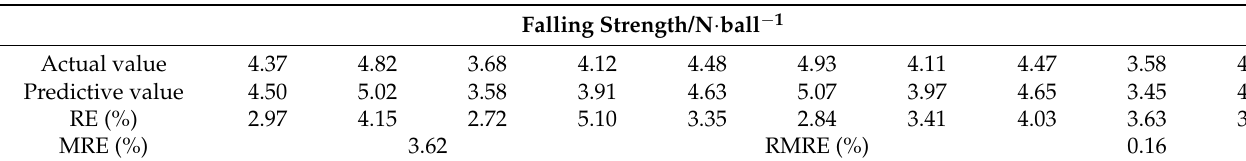
0.38 Figure 8. Variation trend of errors of compressive strength prediction model. In the falling strength prediction model, the smoothing coefficient of the cultural fire- fly algorithm output is 0.11. It can be observed from Table 11 that the relative errors of the 10 sets of validation sets of the drop strength prediction model are between 2.84% and